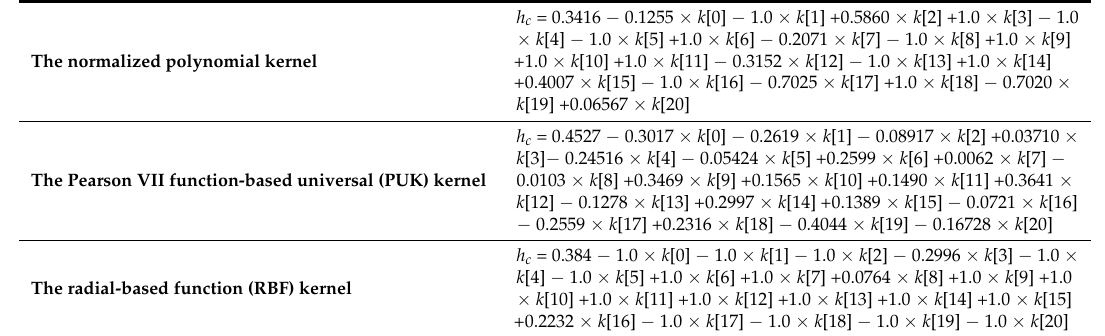
Table 6. Support vectors obtained in SVM regression for h c